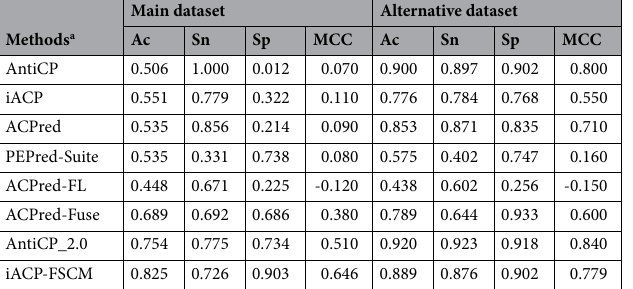
Table 5. Independent test results of the proposed method ACPred-FSCM with state-of-the-art methods as evaluated on main and alternative datasets. a Results obtained from the published findings of AntiCP_2.0 25 .